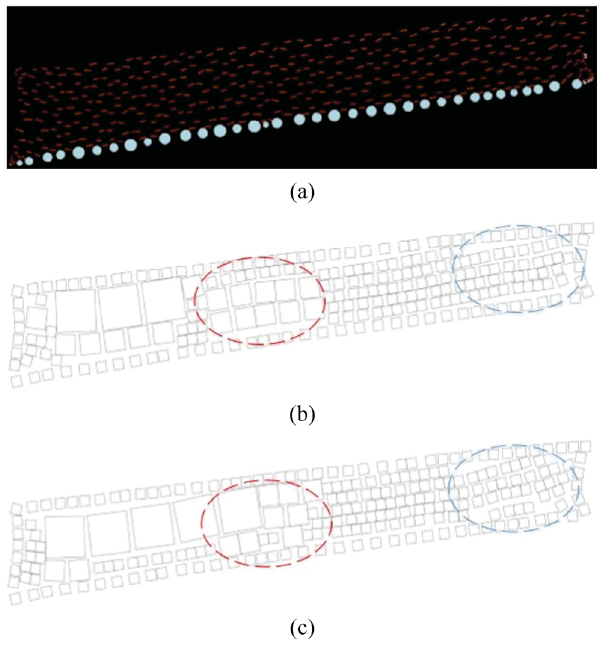
Fig. 8 Use of Gestalt principles. (a) Vector field. Red arrows: direction of the vector field. Blue circles: heat source points. (b) Result generated with Gestalt principles. (c) Result generated without Gestalt principles.